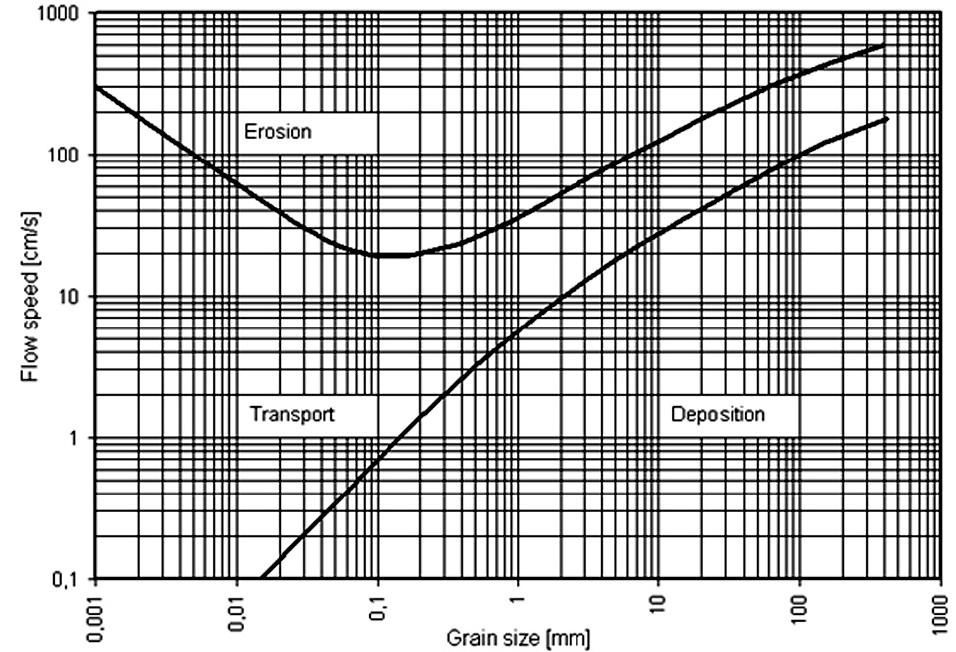
Figure 1. The Hjulstrom diagram. Source: Wikipedia.